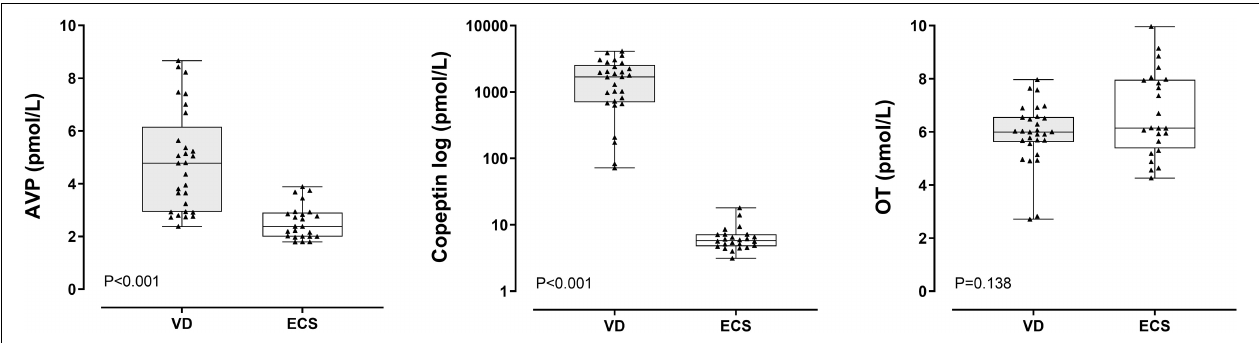
FIGURE 1 | Arginine Vasopressin (AVP), copeptin and oxytocin (OT) levels according to mode of delivery. Comparisons were performed with Mann-Whitney U -test. VD, vaginal delivery; ECS, elective cesarean